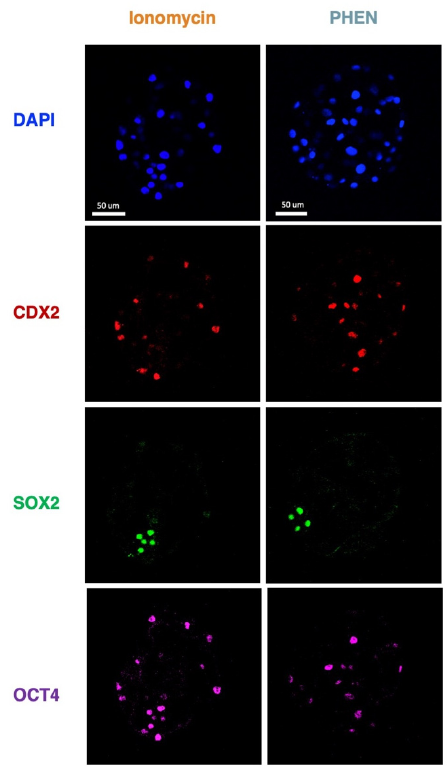
Figure 3. Representative immunofluorescent staining of porcine blastocyst stage embryos of the indicated groups. Scale bars indicate 50 μ m. PHEN, 1,10-phenanthroline.